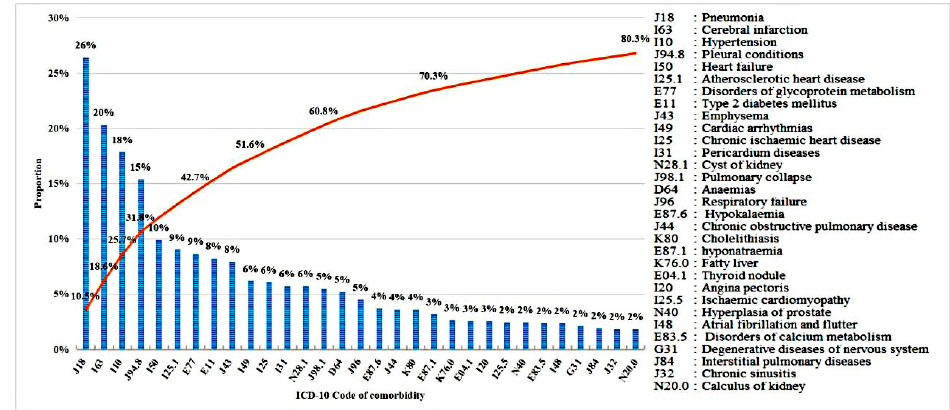
Figure 2. Distribution of the number of patients for each disease ( blue ) and the cumulative proportion ( orange ).